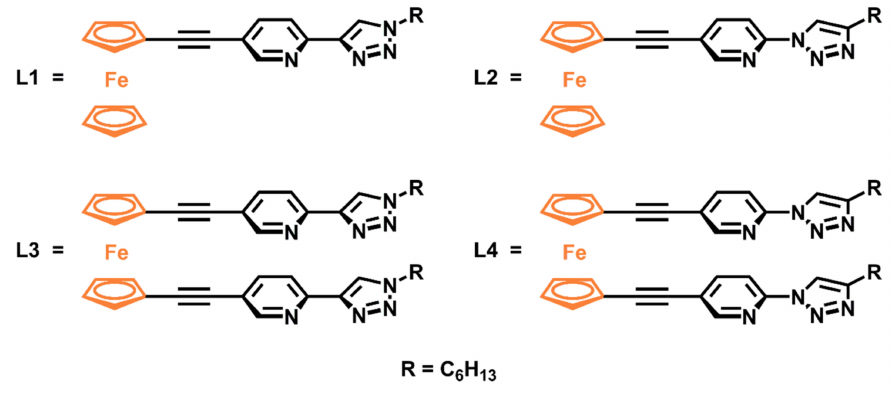
Figure 1. The molecular structures of ferrocene model ( L1 – L2 ) and rotor ligands ( L3 – L4 ).